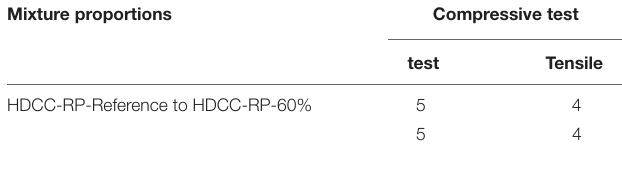
TABLE 2 | Test program of HDCC with different replacement ratios of RP.